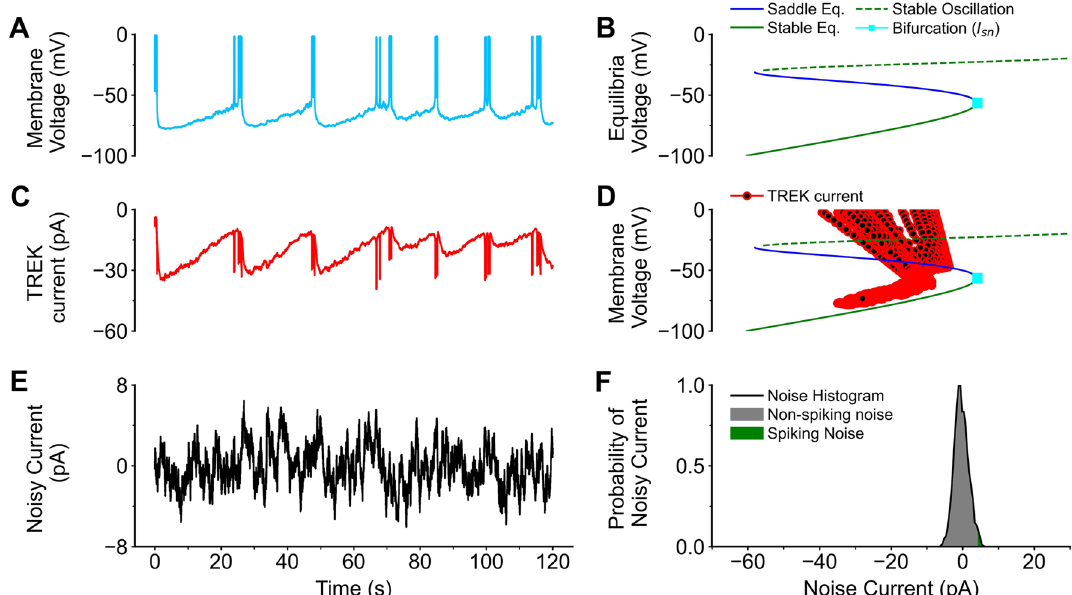
Figure 3. Biophysical properties of starburst amacrine cell. The biophysical properties of starburst amacrine cells (SAC) are driven by spontaneous noise and the slow-afterhyperpolarization (sAHP). ( A ) After noisy channel activity and TREK channels are added in, the membrane voltage ( V t ) forms spikelet and bursts separated by an interburst interval. ( B ) A codimensional-1 analysis was conducted altering the applied current (I app ) without the influence of acetylcholine, GABA, or the sAHP (g ACh = 0, g GABA = 0, g TREK = 0). Lines on the graph indicate the presence of equilibria. Green lines indicate a stable equilibrium. Dashed lines indicate that the equilibria will be the focus of a oscillation. Blue lines indicate a Saddle equilibrium exists. The location of the saddle node current (I sn = 4.09, V sn = − 56.6) represents the excitability threshold. ( B ) TREK1 channels interact with the voltage and are responsible for the sAHP. ( D ) The relationship between the voltage and the sAHP (red line) are overlayed on the equilibria plot. ( C ) Noisy channel activity is added to the model as a current in pA. (F) A histogram samples the distribution of noisy currents. The green shaded area represents spikes that are above the I sn and capable of generating a